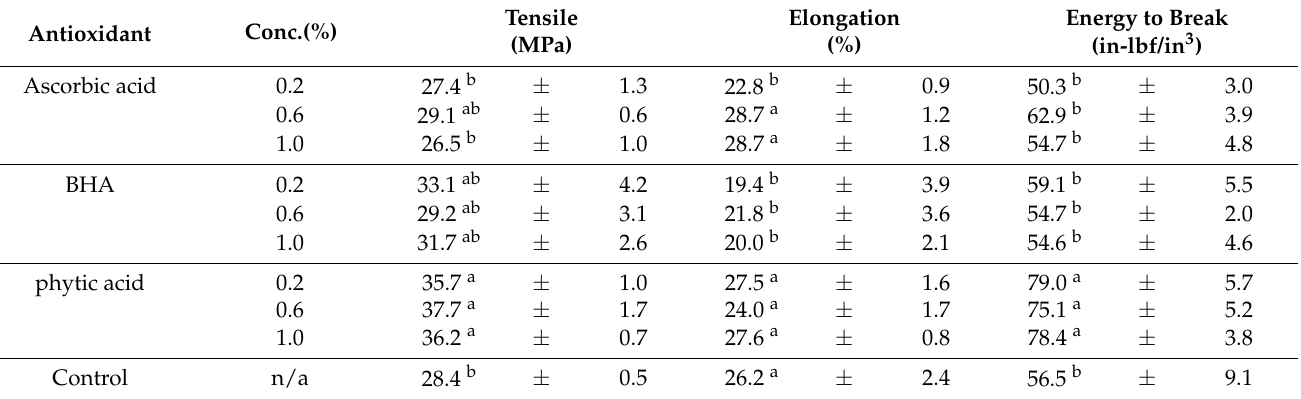
Table 1. Mechanical properties (tensile, elongation at break and energy to break) of GBFs incorporat- ing